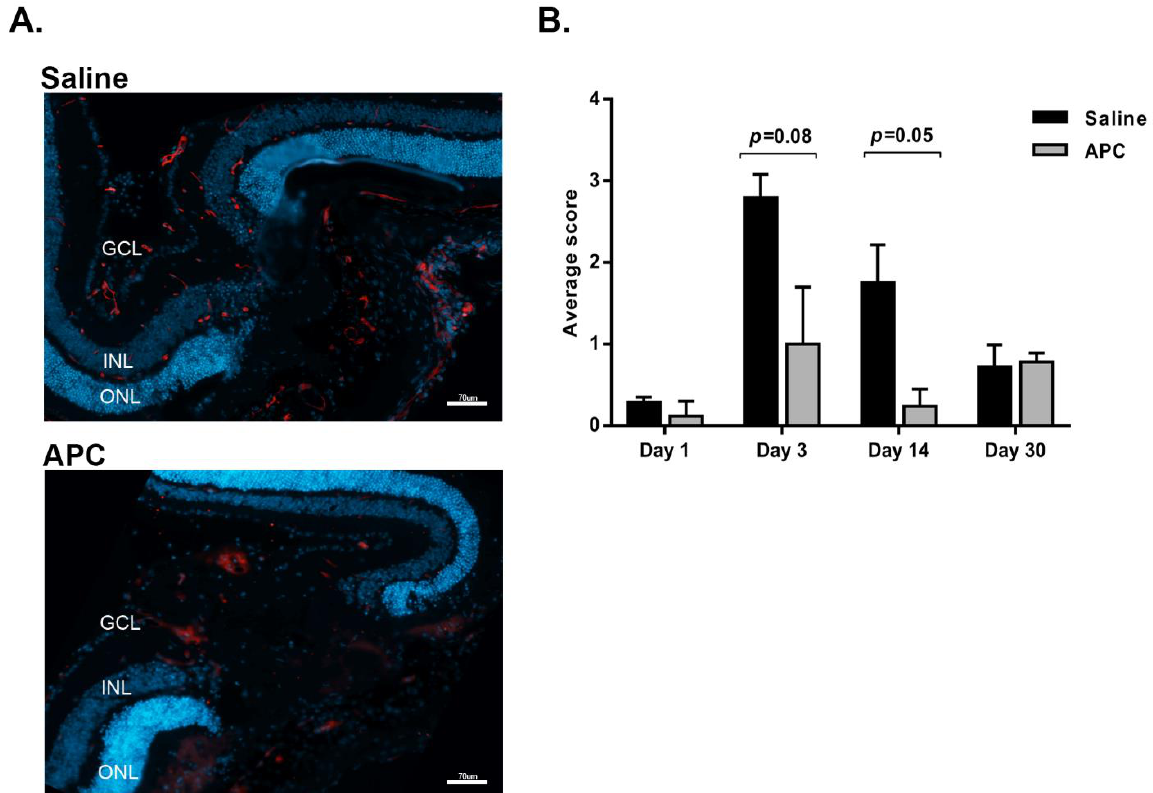
Figure 2. Longitudinal effect of APC on VEGF levels in CNV lesion sites. Immediately following laser applications, APC (1 µg/µL/mouse) or saline were injected intravitreally (ITV), and 1, 3, 14, and 30 days later, mice were sacrificed ( n = 4 mice per group). Sequential cryosections were stained with anti-VEGF antibodies (red), and cell nuclei were stained with DAPI (blue). ( A ) Representative histological sections image of laser lesion sites from mice treated with APC or saline, taken 3 days post treatment. GCL, ganglion cells layer; INL, inner nuclear layer; ONL, outer nuclear layer. Scale bar, 70 µm. Panel ( B ) summarizes the mean scoring of VEGF staining in laser lesion sites. Images of every fifth slide of each eye were captured digitally under the same settings, and VEGF staining was scored from 0–3 (light to heavy staining, respectively) by 2 masked observers. Twenty images per group were used for analysis. The data are presented as mean ± SD and were analyzed using unpaired two-tailed Student’s t test (the resulting p values were adjusted for four time points using Sidak’s correction).